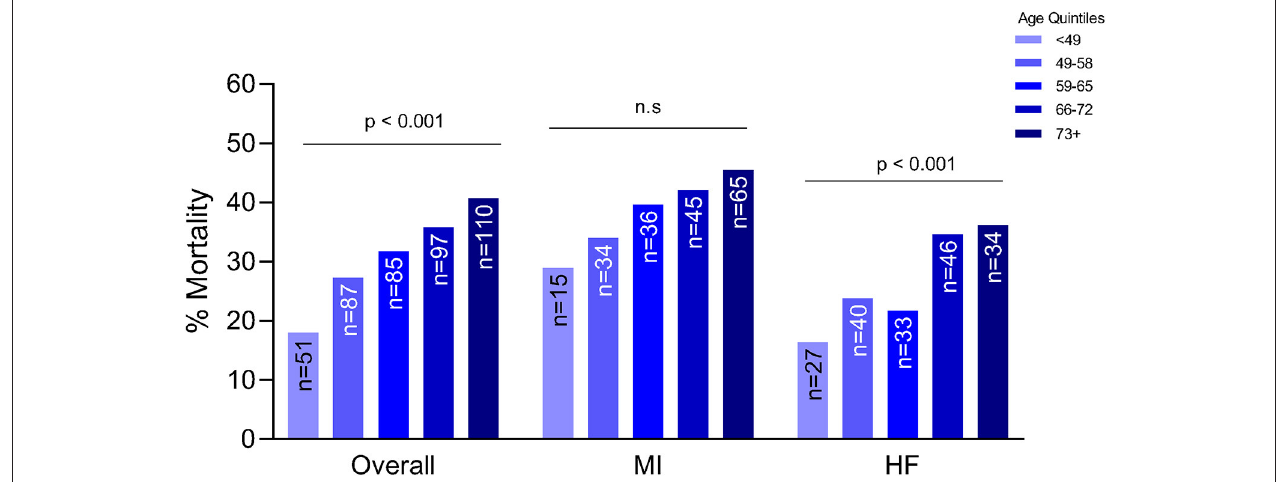
FIGURE 1 | Association between age and mortality by etiology of cardiogenic shock. MI, myocardial infarction; HF, heart failure; n.s., not significant